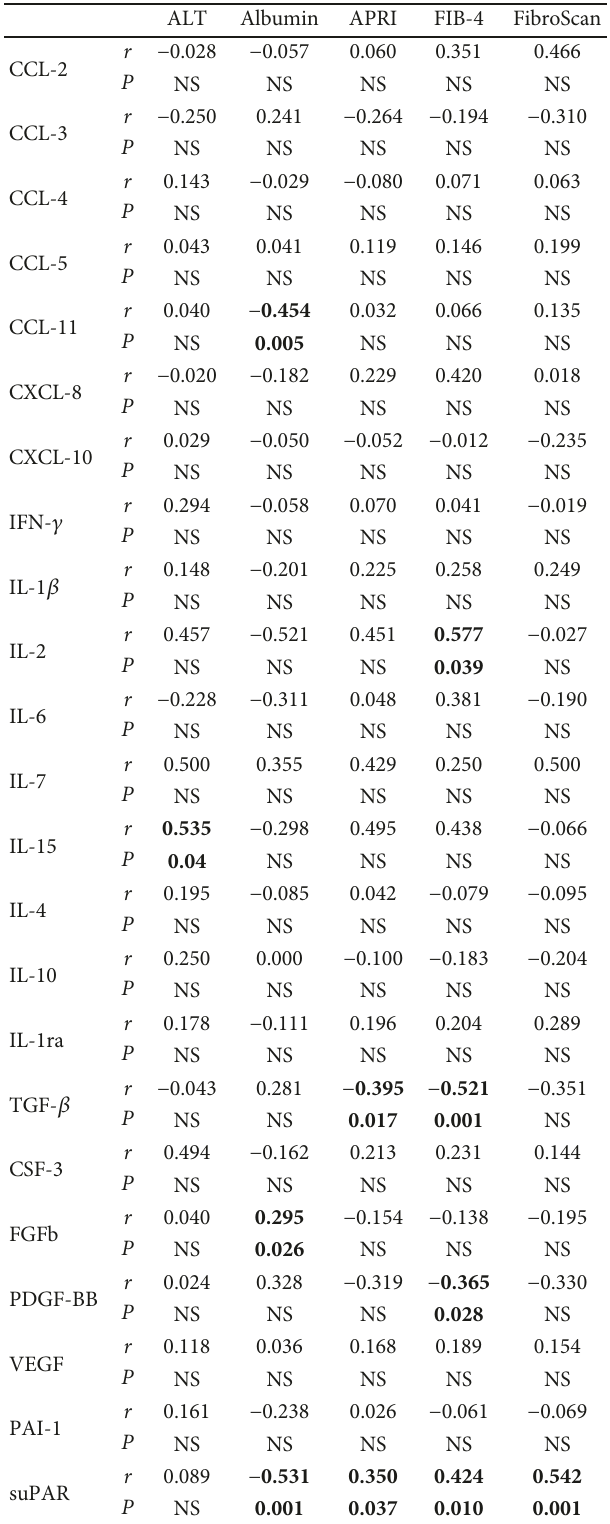
Table 4: Correlation between cytokines and noninvasive methodologies for liver injury